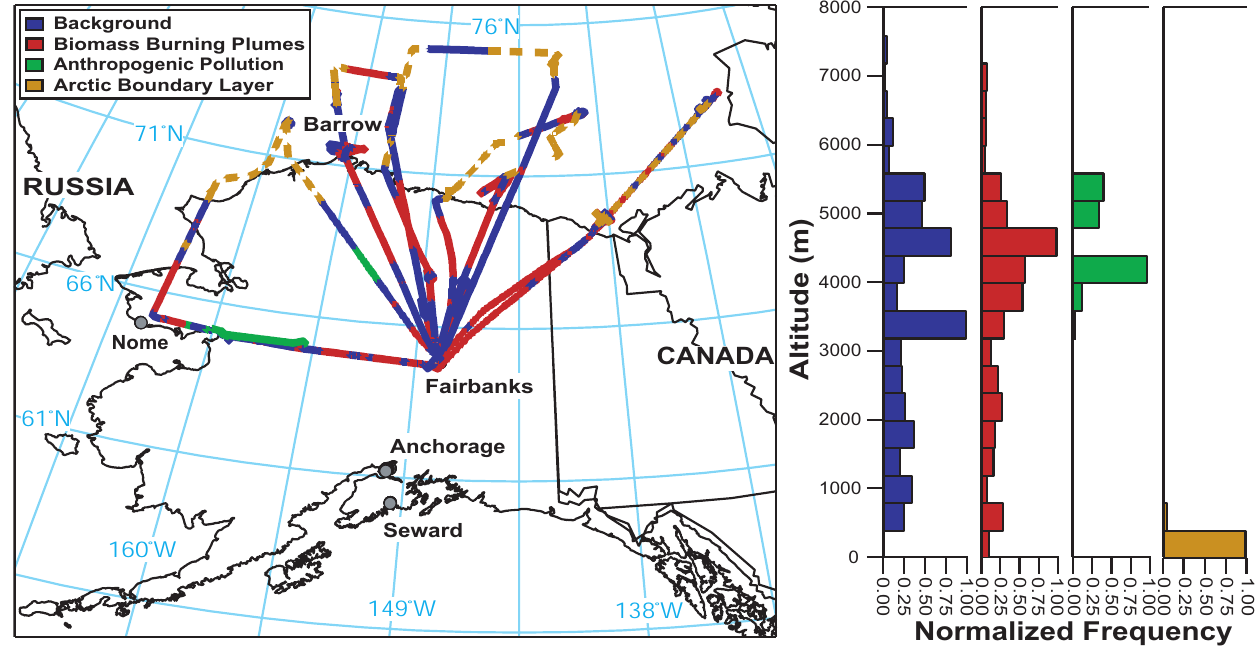
Fig. 1. (Left) Aircraft trajectories for the research flights on April 12th, 15th, 18th, 19th, and 21st, colored by air mass type. Due to vertical profiling, some air mass types overlap. (Right) Vertical profiles showing the altitudes at which each air mass type (background, biomass burning plumes, anthropogenic plumes, Arctic boundary layer) was frequently encountered.